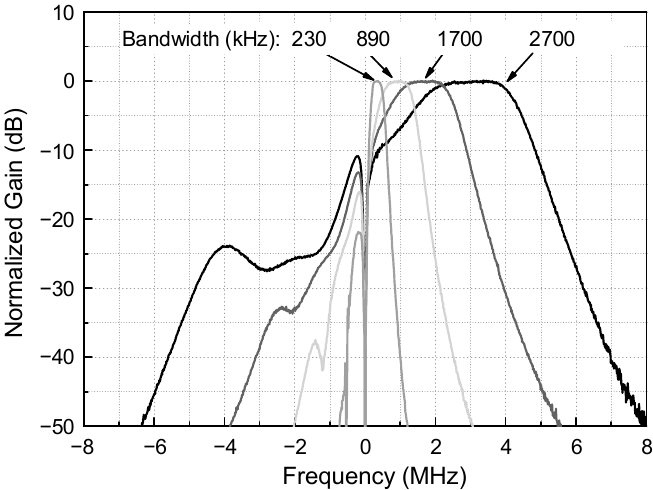
Figure 10. Measured frequency response of the complex BPF. Figure 11 is the measured phase noise of the PLL synthesizer at the output frequency of 400 MHz. The measured phase noise is − 98.7 and − 125.3 dBc/Hz at 100 kHz and 1 MHz offsets, respectively. The phase noise performance is comparable to the previously reported similar LC VCOs in [12,17], whereas it is much better than [30] for the same MedRadio applications because of the LC cross-coupled structure rather than the ring oscillator structure.